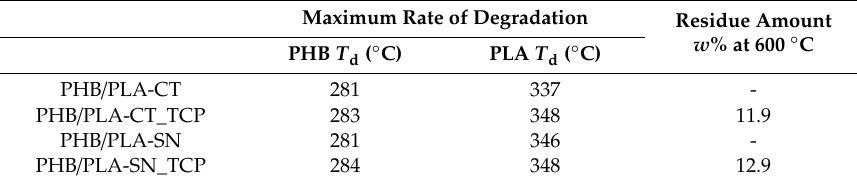
Figure 2. TGA curves of prepared samples. Table 4. The results of